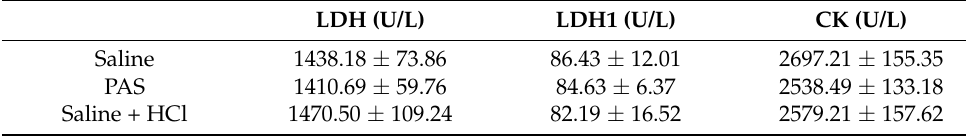
Table 3. Analysis of myocardium